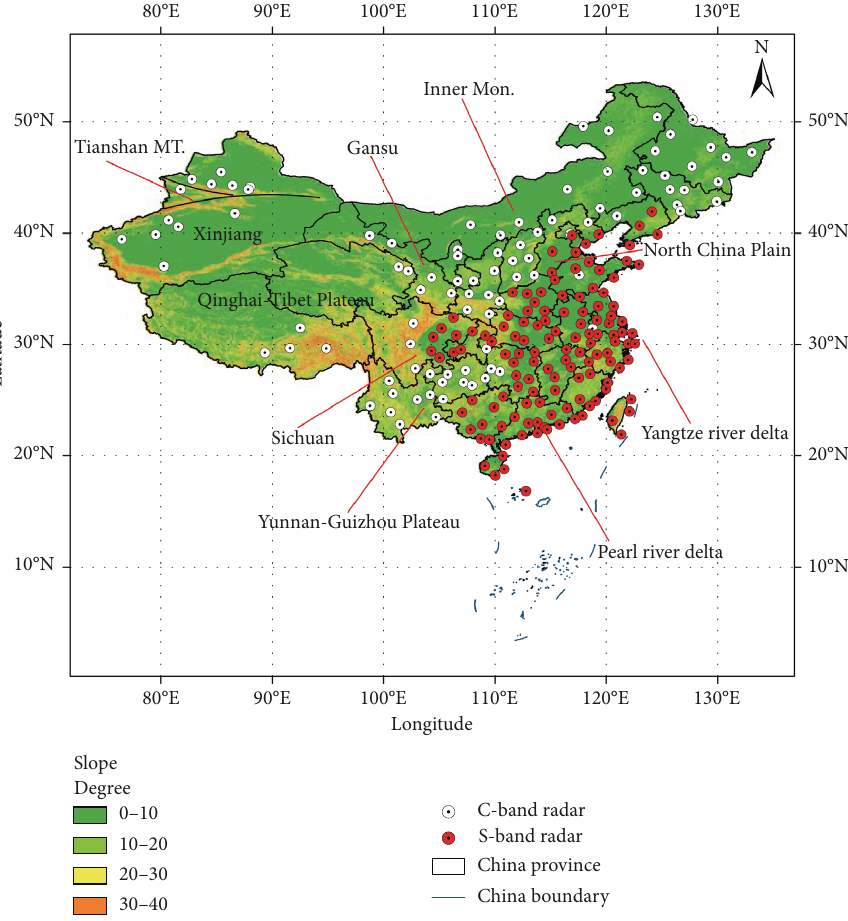
Figure 2: Slope (degree) map of China showing distributions of the CINRAD. White dots represent C-band radars, and red dots refer to the S-band